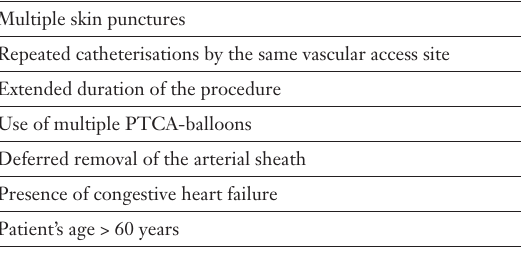
Risk factors for bacteraemia asso- ciated with cardiac catheterisation/ PCI